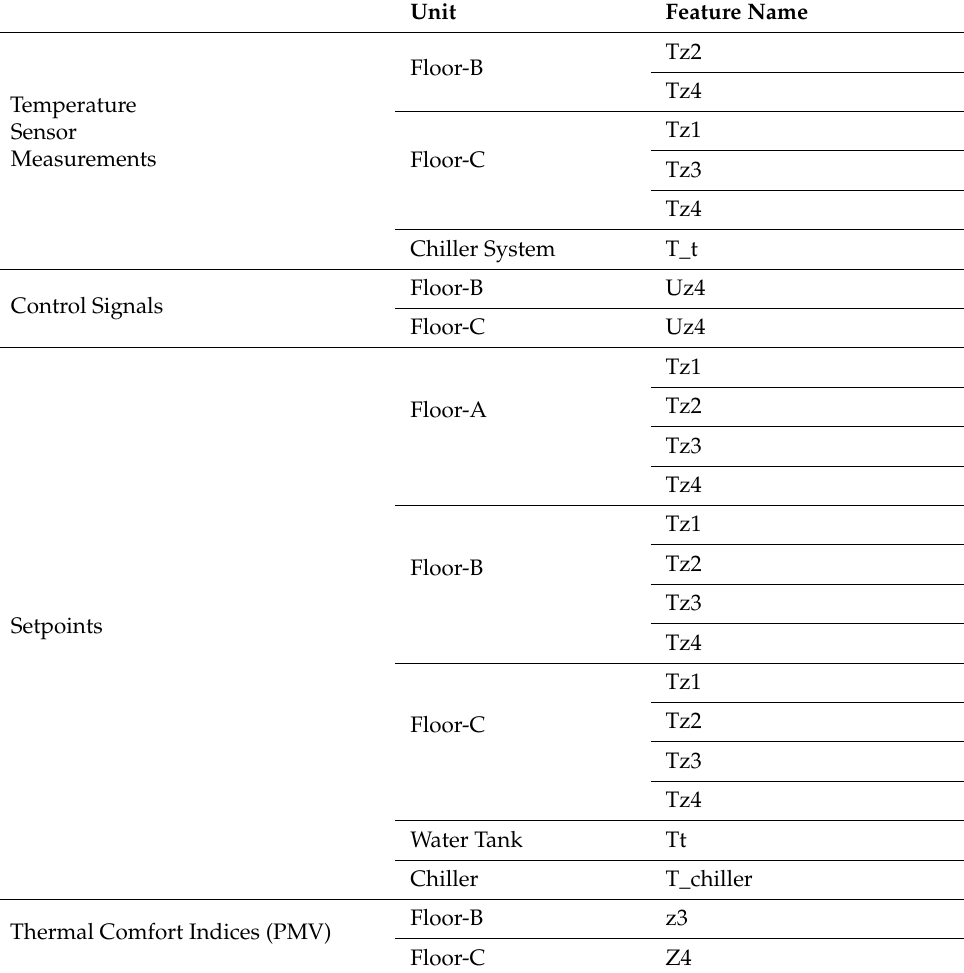
Table 4. Selected features using step forward feature